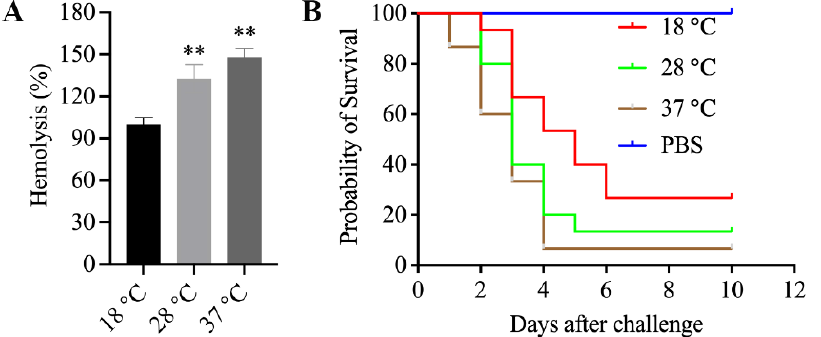
Figure 7. Hemolytic activity and toxicity of ECPs isolated from A . salmonicida cultured under different temperatures. ( A ) shows the hemolysis (%) histogram of A . salmonicida ECPs from different culture temperatures; ( B ) is the number of E . coioides that survived after injection with ECPs of A . salmonicida from different culture temperatures. Data are presented as mean ± standard deviation (SD) ( n = 3). ** p < 0.01.